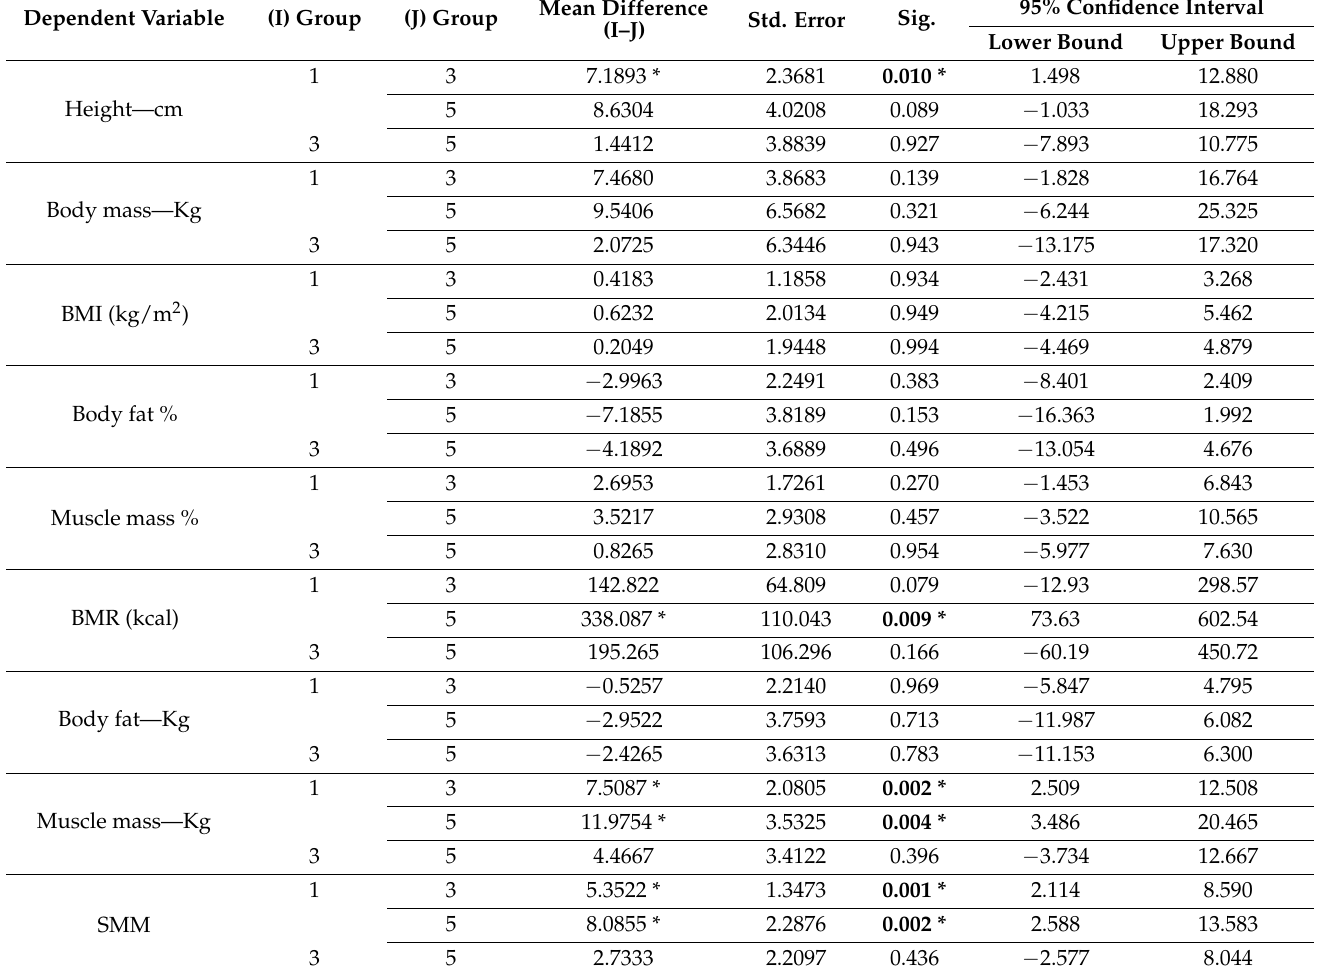
Table 4. The Post Hoc analysis for the morphofunctional parameters for groups of boys.